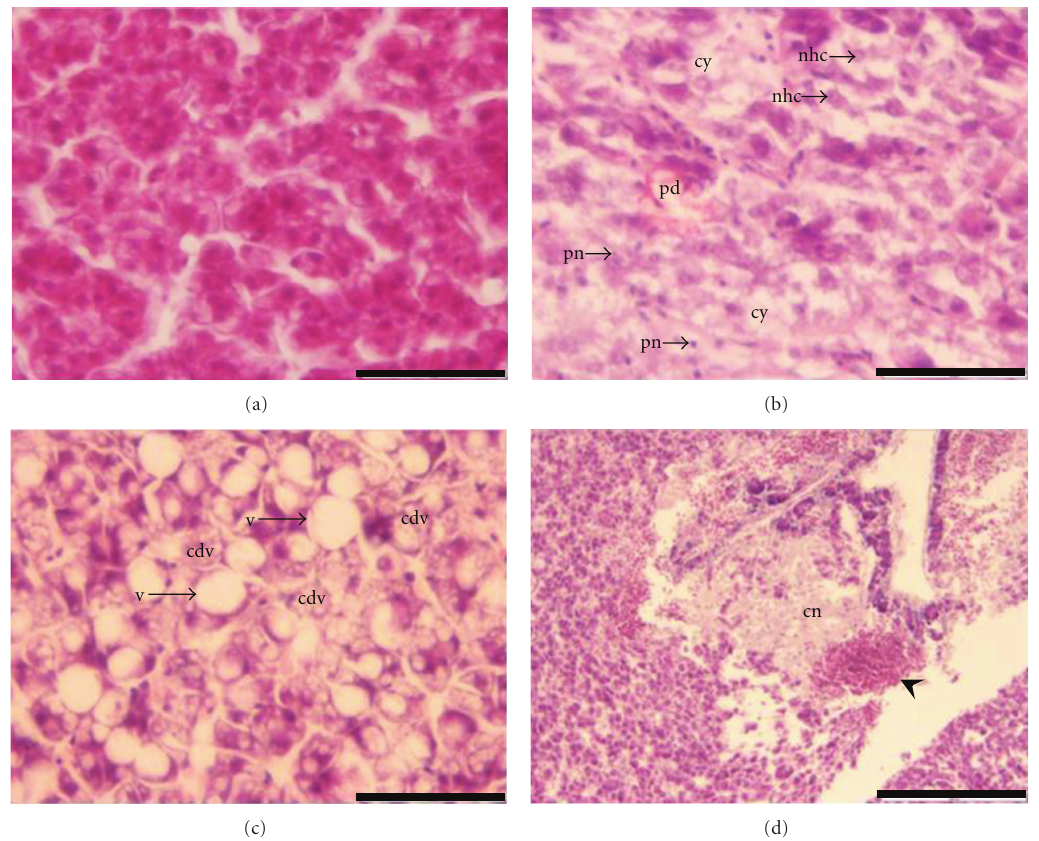
Figure 1: Histopathological observations in the liver of Diplodus cervinus after 28 days of exposure. (a) control group: section of polygonal hepatocytes cords (bar = 50 µ m); (b) exposure to Hg 2+ : extensive necrosis with congestion of sinusoids and pigment deposition (pd), nuclear hypercromatose (nhc), picnotic nucleus (pn) and cytolysis (cy) (bar = 50 µ m); (c) exposure to MeHg: extensive cytoplasmic degenerative vacuolization (cdv) with large, smooth-edged vacuoles (v) (bar = 50 µ m); (d) co-exposure to MeHg and Se: focal coagulative necrosis (cn) associated to blood congestion (arrowhead) (bar = 200 µ